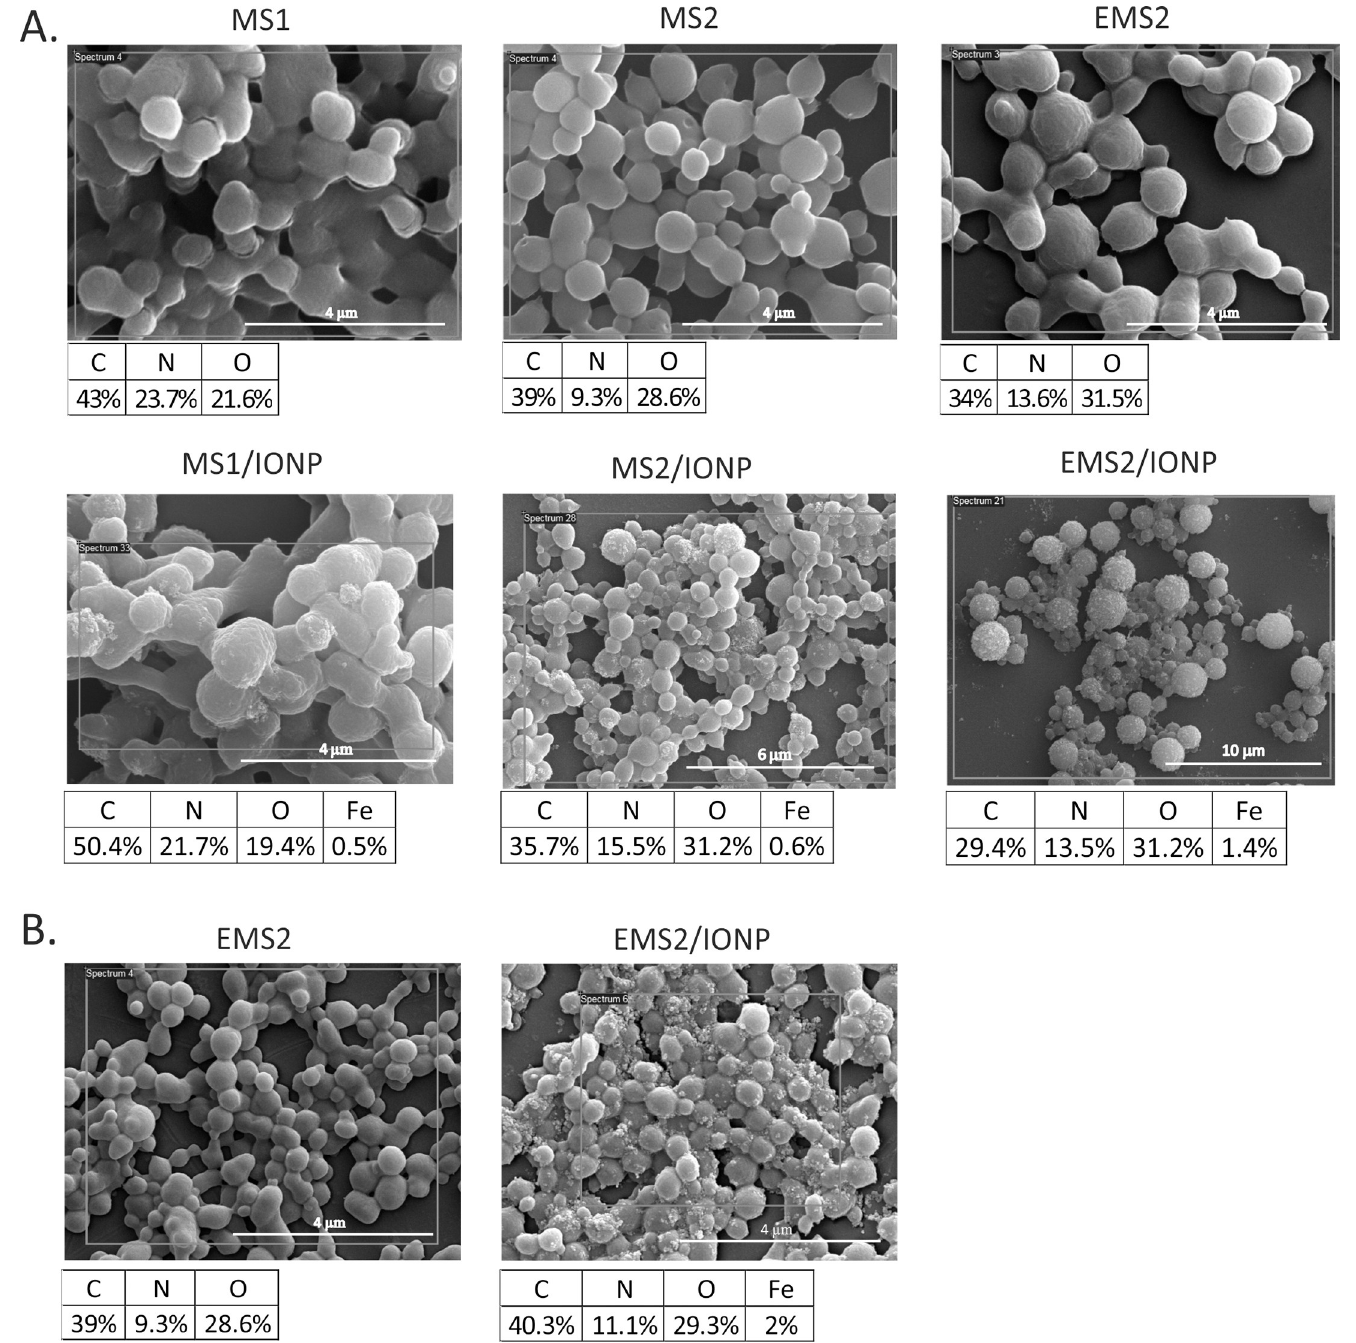
Fig 2. SEM images and EDXS quantitative results of selected elements of MS1, MS1/IONP spheres, MS2, MS2/IONP spheres, EMS2, and EMS2/IONP spheres. A) Spheres were prepared by mixing 2 M potassium phosphate at pH 8 with the indicated version of silk (2.5 mg/mL) in the presence or absence of iron oxide nanoparticles (5 mg/mL). B) EMS2 and EMS2/IONP spheres were formed by mixing 2 M potassium phosphate at pH 8 with a silk solution (1 mg/mL) in the presence or absence of the iron oxide nanoparticles (5 mg/mL); scale bar– 4 μ m. particles, we reduced the initial silk concentration before the sphere formation. The spheres formed by mixing silk at a concentration of 1 mg/mL with a potassium phosphate buffer had a